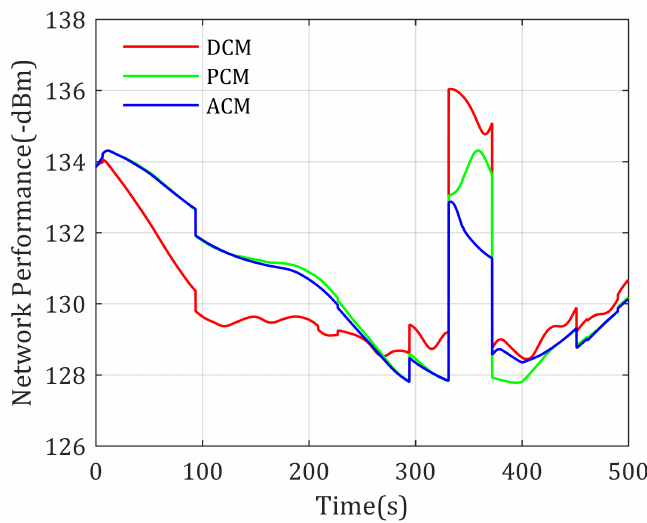
Figure 13. Network performance for multi-mobile-agents-inter communication with known channel